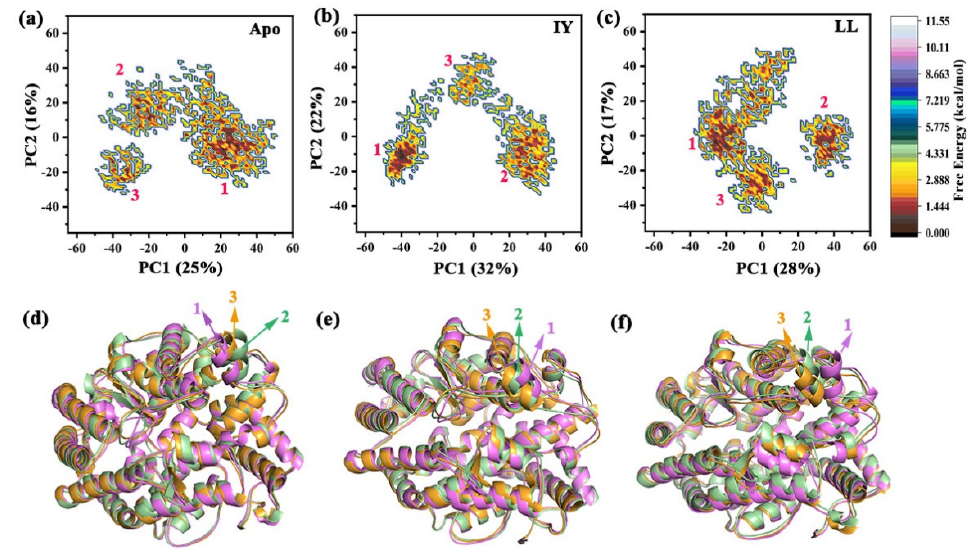
Figure 10. Two-dimensional free energy landscapes (FELs) created by projecting the principal components PC1 (principal component 1) and PC2 (principal component 2) for ( a ) Apo, ( b ) ACE–IY, and ( c ) ACE–LL; the representative structures of ( d ) Apo, ( e ) ACE–IY, ( f ) ACE–LL from cluster analysis are shown in the below panel. Apo means ligand-free protein, ACE–IY stands for complex system of protein and dipeptide Ile-Tyr, ACE–LL represents the complex system of protein and dipeptide Leu-Leu.